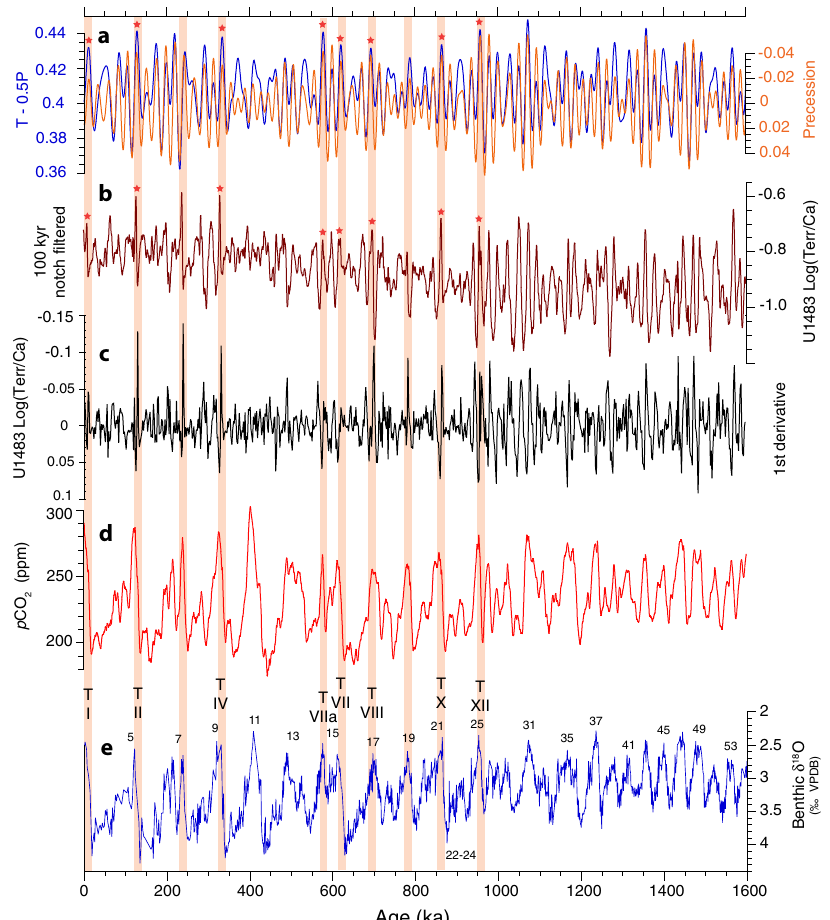
Fig. 6 | Enhanced response of Australian Summer Monsoon associated with high-latitudewarming,risingatmospheric p CO 2 ,andice-sheetcollapseduring the fi nal stage of glacial terminations following the Middle Pleistocene Tran- sition. a Composite of obliquity (T) and precession ( − 0.5P) and precession para- meter with maximum in NH summer solstice (-P) from ref. 119. Red stars mark intensi fi cationofmonsoonalrainfallattheendofTerminations(T)I,II,IV,VIIa,VII, VIII, X, and XII under the combined insolation forcing of obliquity maxima and precession minima. b U1483 Log(Terr/Ca) after removal of low-frequency varia- bilityusingGaussiannotch fi lterwithbandwidthof0.01centeredatthefrequency